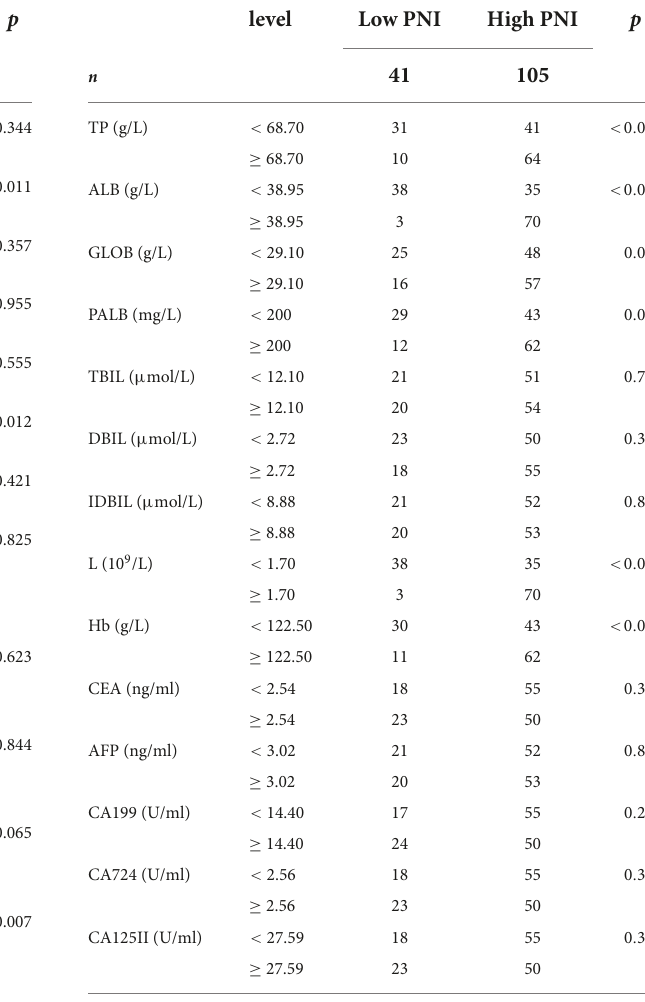
TABLE 1 The clinical information of all patients. TABLE 2 The blood parameters of all